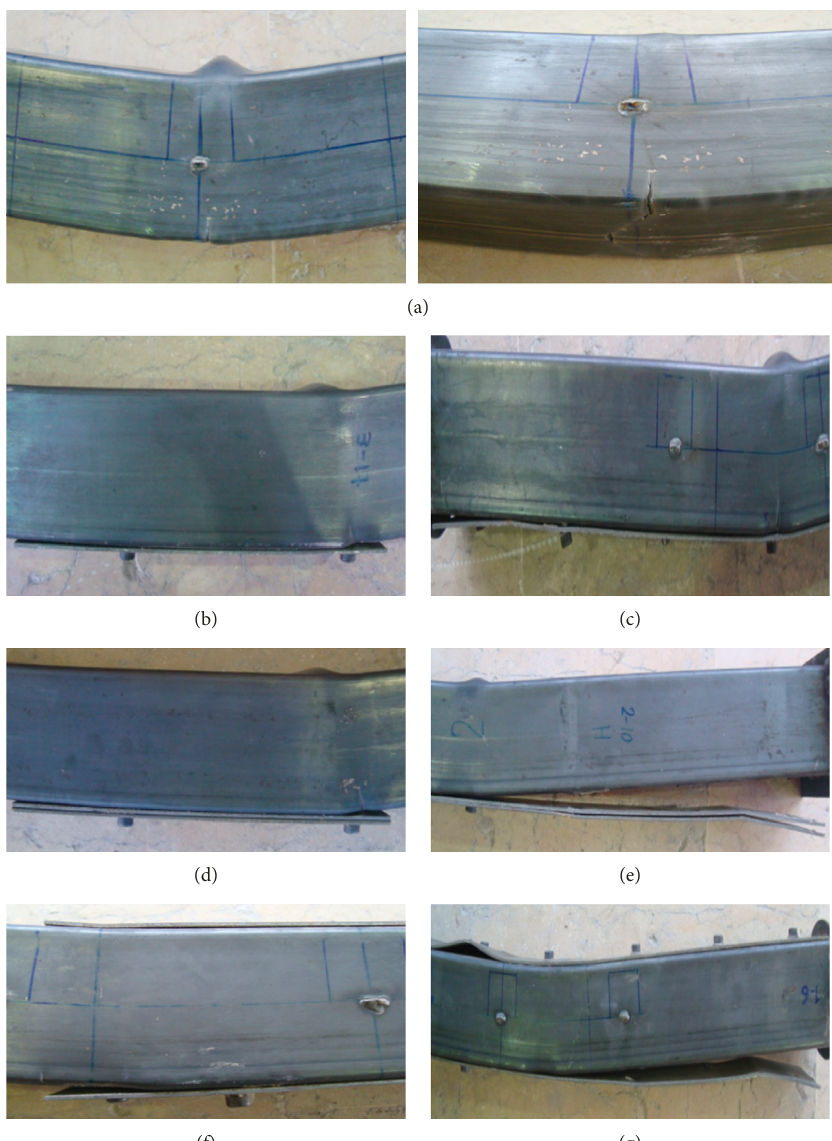
Figure 9: Failure modes of control and retrofitted beams. (a) Typical local buckling and rupture of control beam. (b) RB-PL-SB. (c) RB-FL- SB. (d) RB-PL-DB. (e) RB-FL-DB. (f) RB-PL-TB. (g)